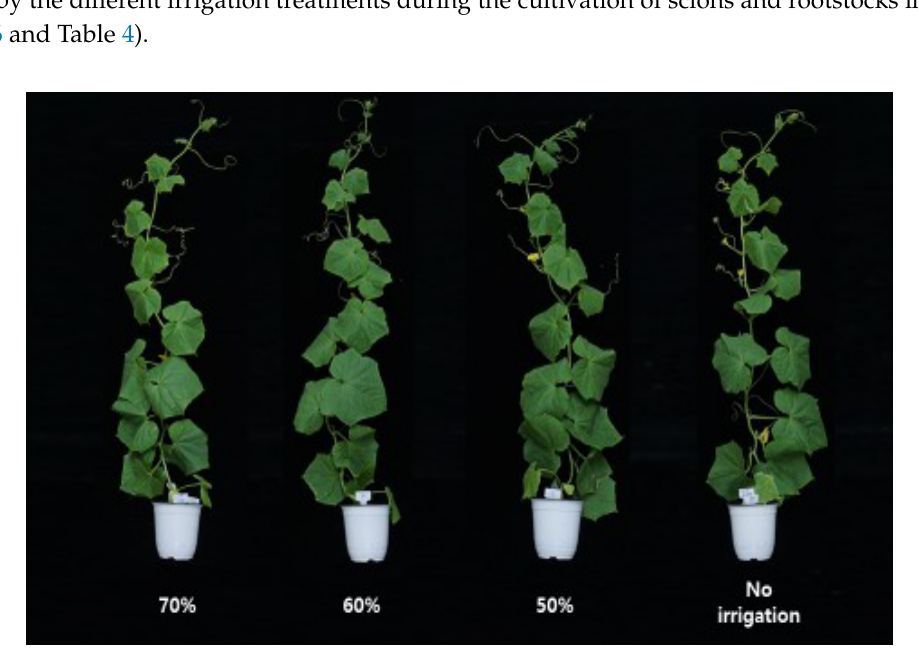
Figure 6. Grafted cucumber seedlings after transplanting as affected by different irrigation regimens during the cultivation of scions and rootstocks in a PFAL.